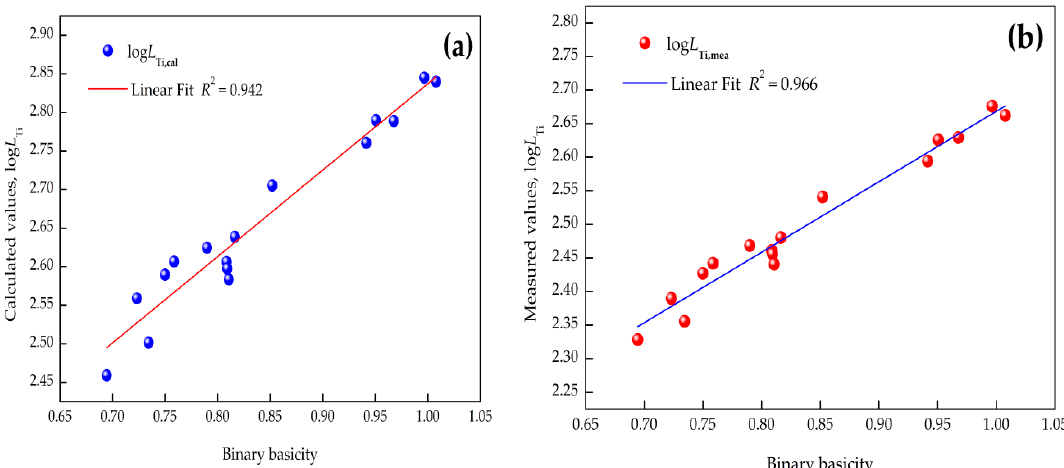
Figure 3. Correlation between binary basicity and titanium distribution ratio: ( a ) calculated by IMCT; ( b ) industrial measurements. Processes 2019 , 7 , x FOR PEER REVIEW 10 of 13